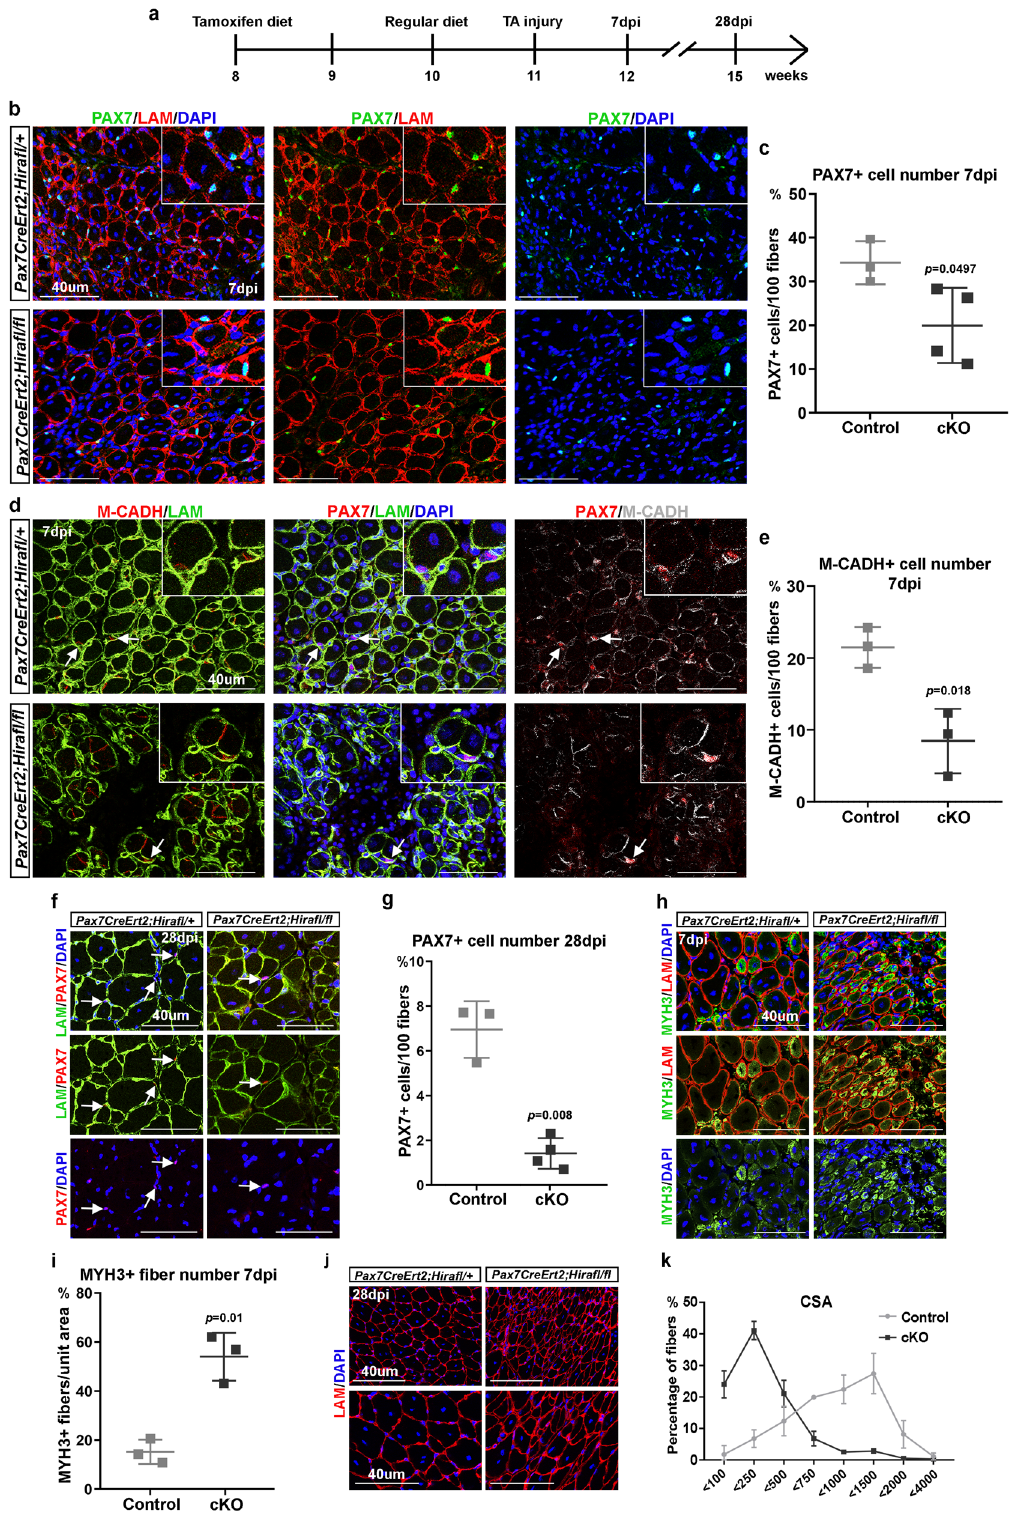
Hira -de fi cient satellite cells lose myogenic cell identity . Satellite cells lacking Hira are unable to sustain muscle regeneration. In order to analyze if Hira -de fi cient muscle stem cells display an alteration of lineage-speci fi c gene expression, as observed in C2C12 cells, we performed RNA-seq on 5 dpi FACS-isolated satellite cells from control ( Pax7 CreErt2 ;Hira fl / + ) and cKO ( Pax7 CreErt2 ;Hira fl / fl ) mice. Sorted satellite cells were further